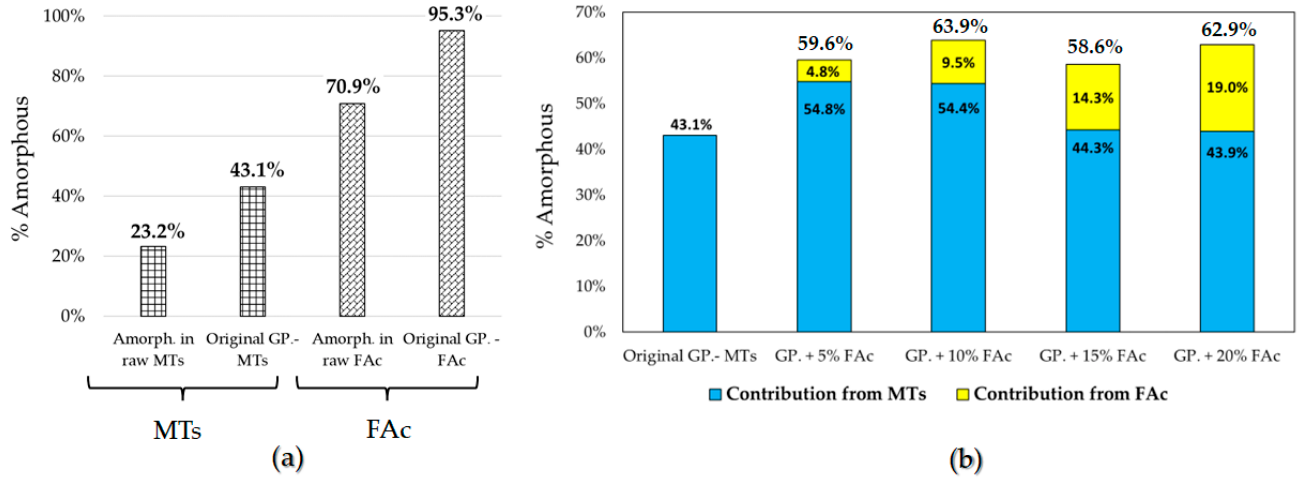
Figure 7. Percentage of amorphous phases calculated QXRD analysis. ( a ) Amorphous content in the raw precursors (raw MTs, raw FAc) and in their individual geopolymer systems. ( b ) content in the original GP.-MTs, and contribution of amorphous content from each precursor in the co-geopolymerized samples .